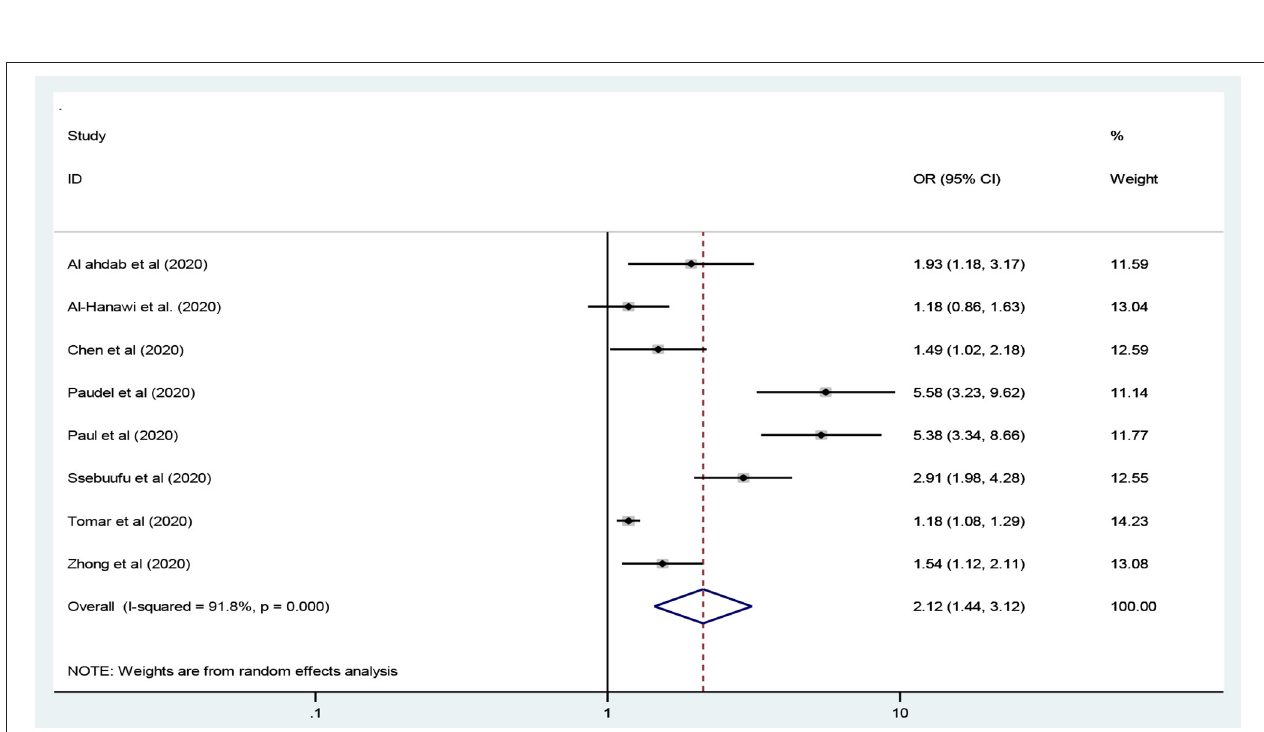
FIGURE 7 | The education level of the participants and preventive practice toward COVID-19.